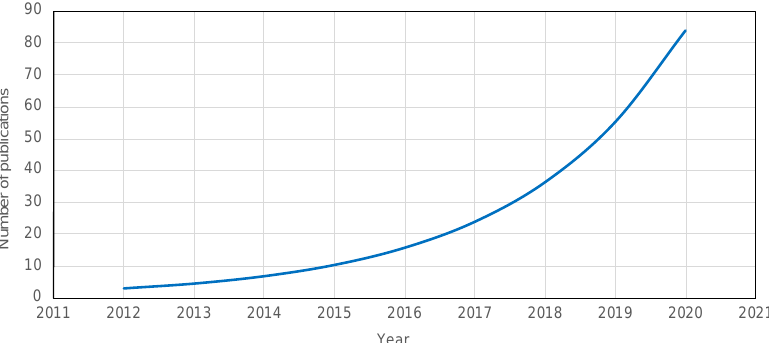
Figure 1. Number of publications in Catalysts journal in the period 2012–2020, using “deactivation” or “regeneration” search terms, according to Scopus TM .